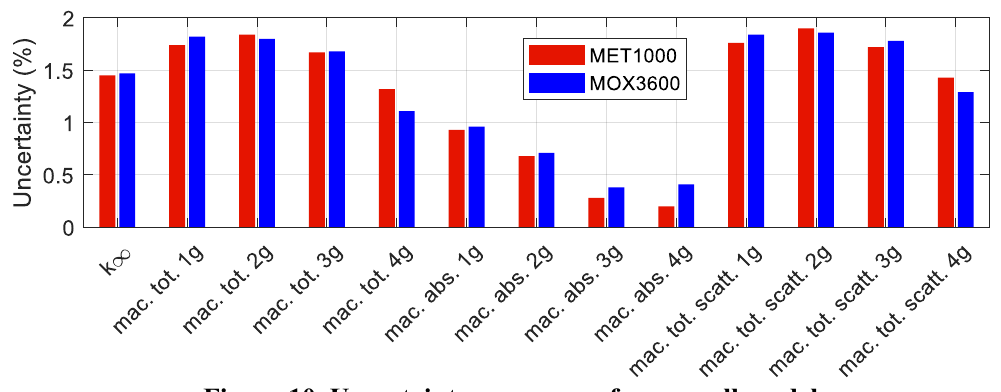
Figure 10. Uncertainty summary of super-cell models